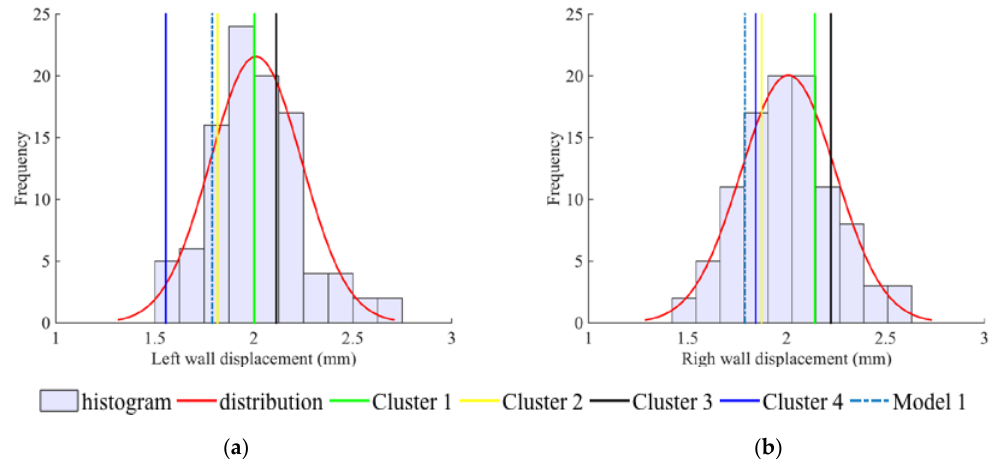
Figure 14. Histograms and distribution fitting curve for the 100 realisations and values (lines) for models 1 to 5 values (lines) of displacements in: ( a ) the centre of the left sidewall; ( b ) the centre of the right sidewall. Table 7. Distribution curve fitting details (first three moments) regarding the 100 realisations’ obtained values for displacements.